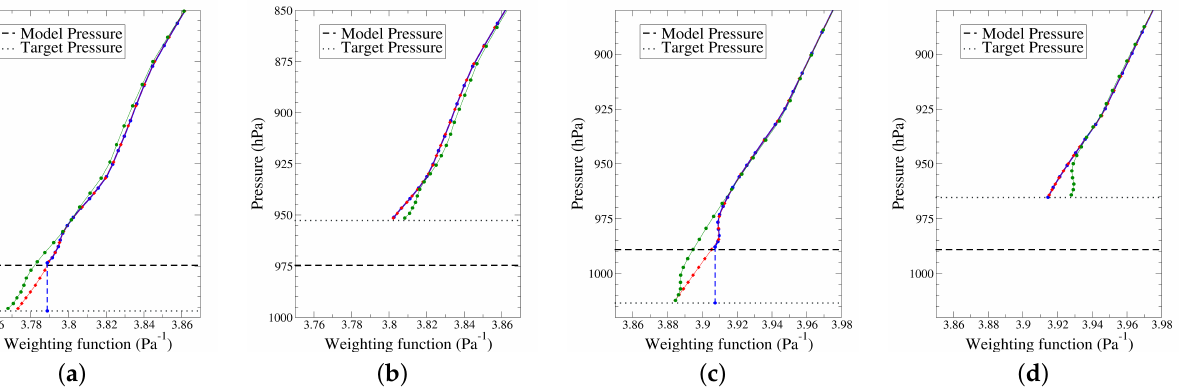
Figure 6. Methane weighting functions obtained according to different extrapolations: with zero gradient in blue, standard gradient in red and APACHE method in green. Two examples: the first one over Africa, the second over the Alps. ( a , c ) with a target below the model topography. ( b , d ) with a target above the model topography.